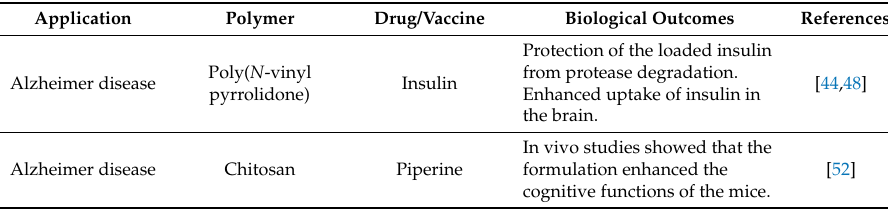
Table 1. Nanogel gel for intranasal